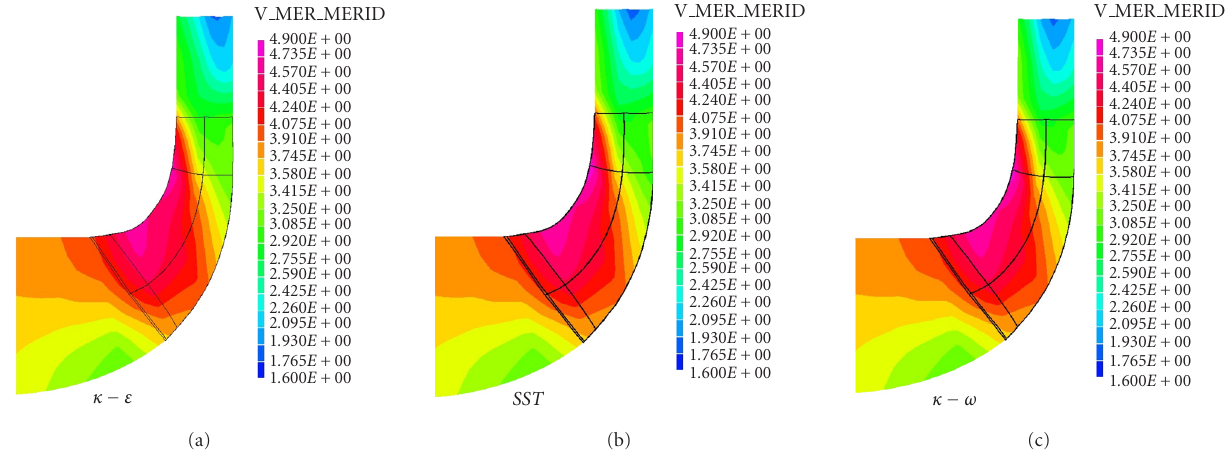
Figure 7: Influence of turbulence model on the meridional velocity field.